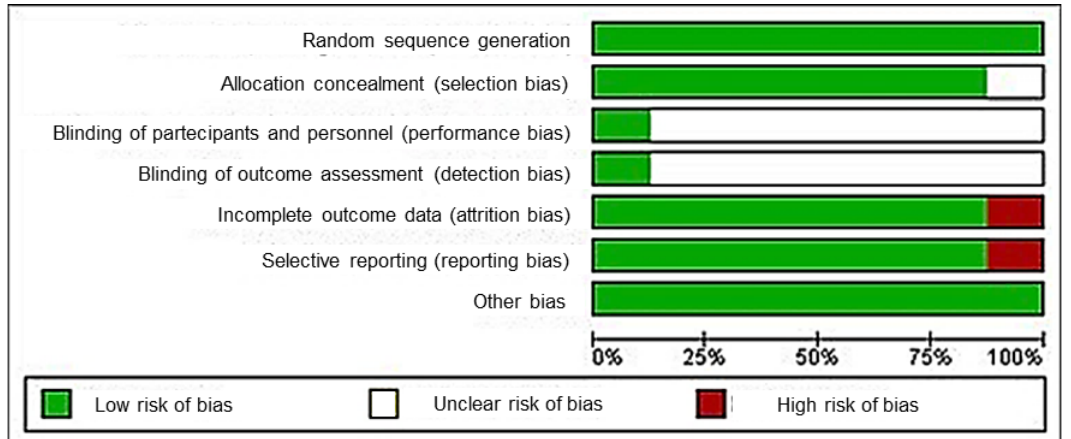
Figure 2. Risk of bias graph about each risk of bias item presented as percentages across all included studies (green dot: low risk of bias; red dot: high risk of bias).